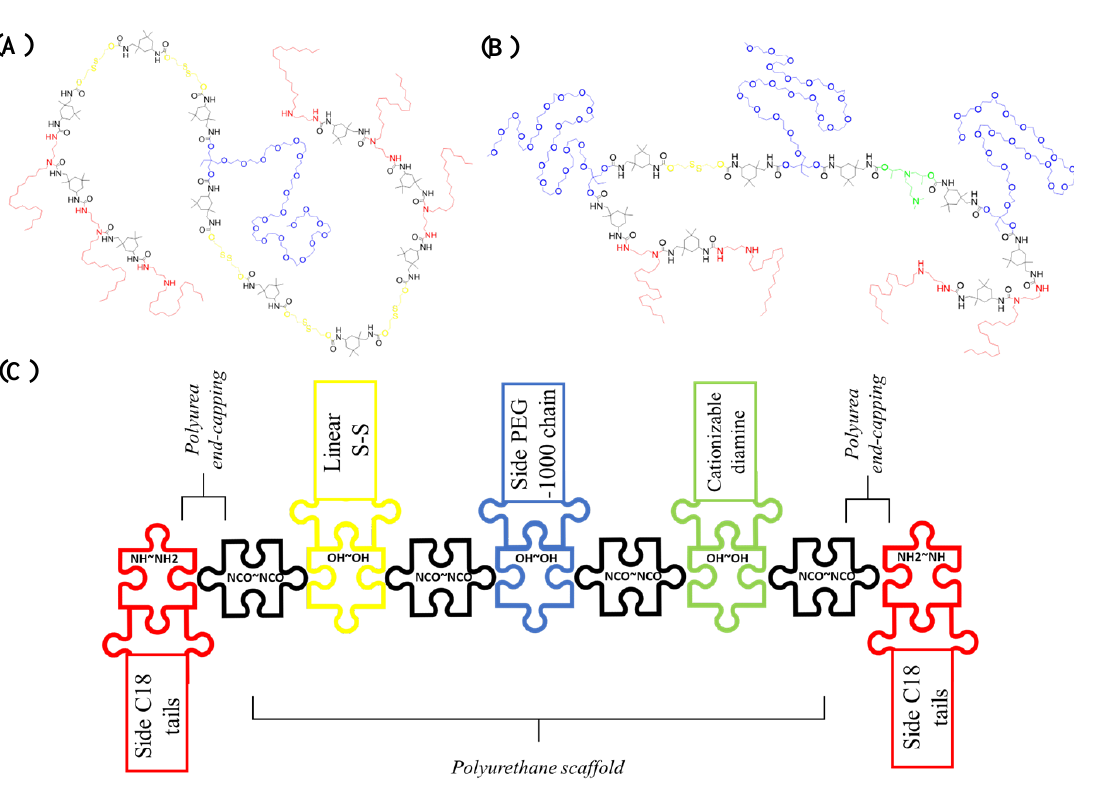
Figure 1. Chemical structure of polyurethane-polyurea hybrid prepolymers P1 ( A ) and P2 ( B ), and schematization of P2 synthesis ( C ), where the polyurethane backbone was initially designed to be afterwards end-capped with the amino groups from a hydrophobic diamine, furnishing the hybrid polyurethane-polyurea prepolymer.